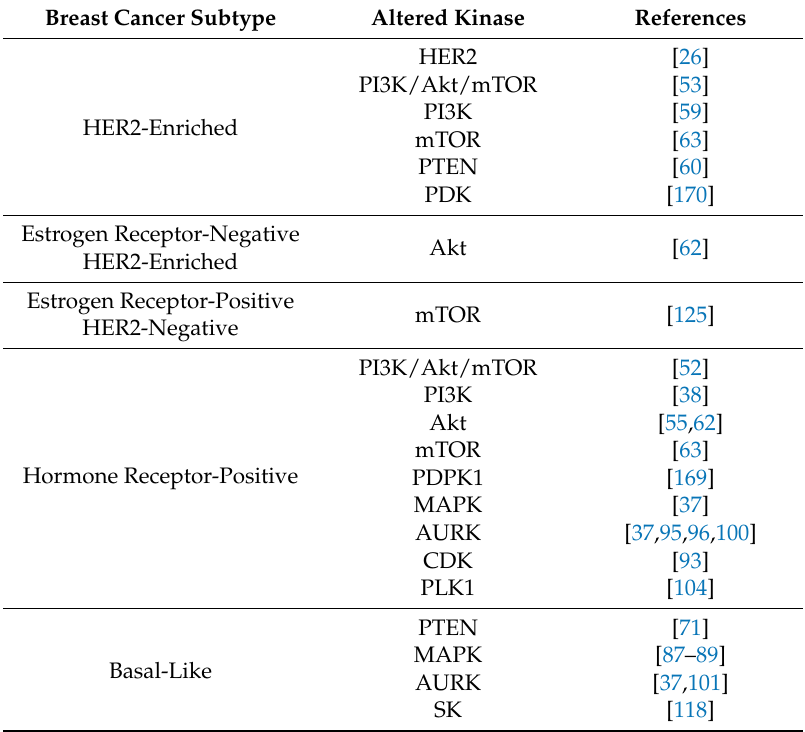
Table 15. Altered expression of kinases in different breast cancer subtypes. Breast Cancer Subtype Altered